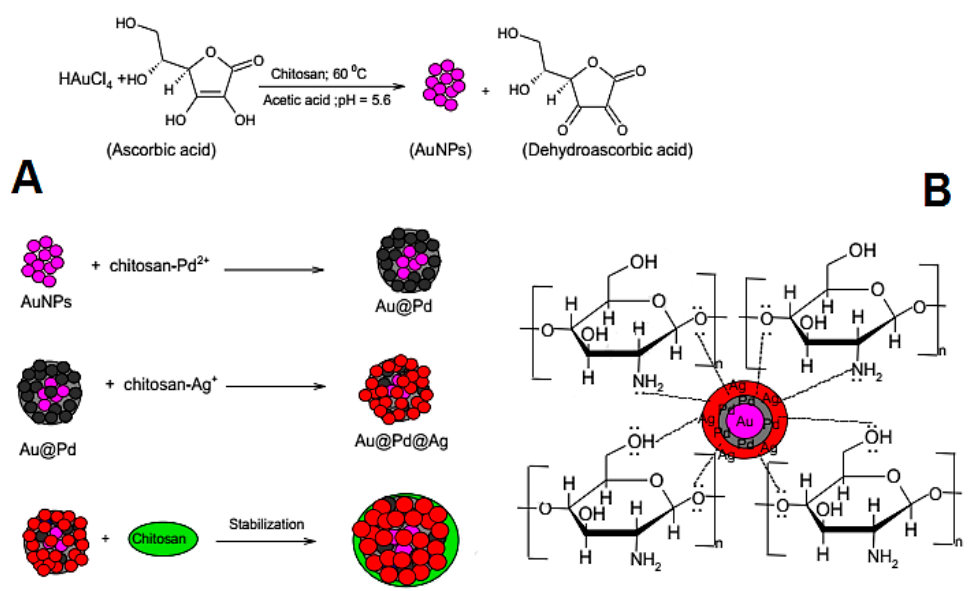
Figure 6. Schematic representation of seedless formation of Au-Pd-Ag NPs ( A ) and their stabilization using chitosan as capping agent ( B ). Reproduced from [103], with permission from Elsevier, 2020.